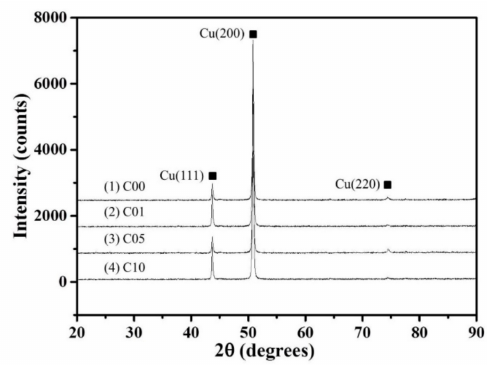
Figure 2. XRD patterns of Cu–1.8Fe alloys with and without addition of